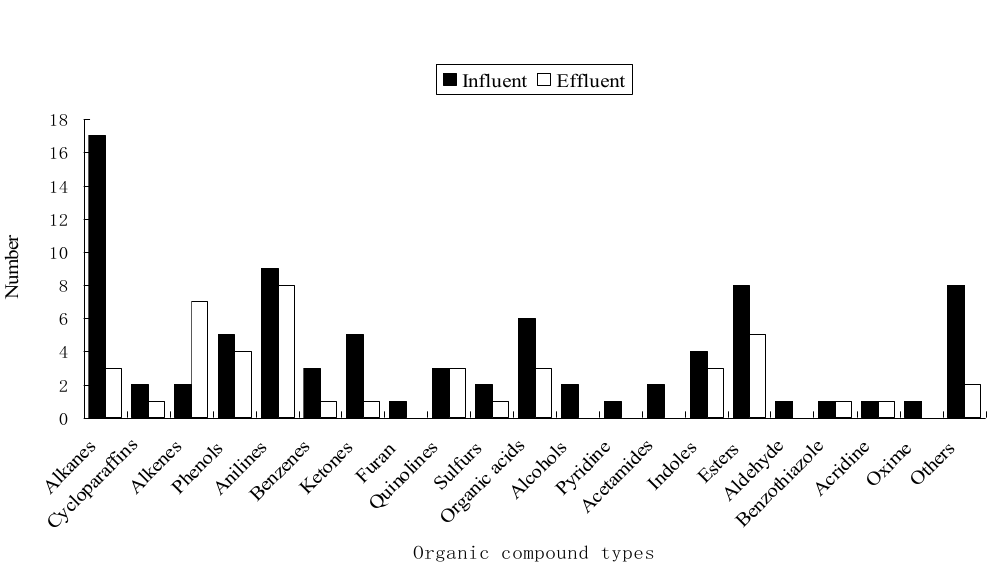
Figure 5. Numbers of the organic compound type in the hybrid anaerobic baffled reactor (HABR) influent and effluent.